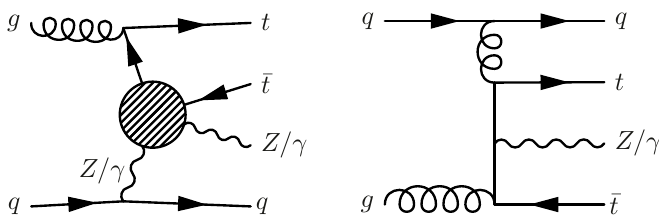
Left : schematic Feynman diagram for the EW-induced t (cid:22) t ( Z=(cid:13) ) j process and its embedding of the t Z t Z , t Z t (cid:13) or t (cid:13) t (cid:13) subamplitudes. Right : sample ! ! !